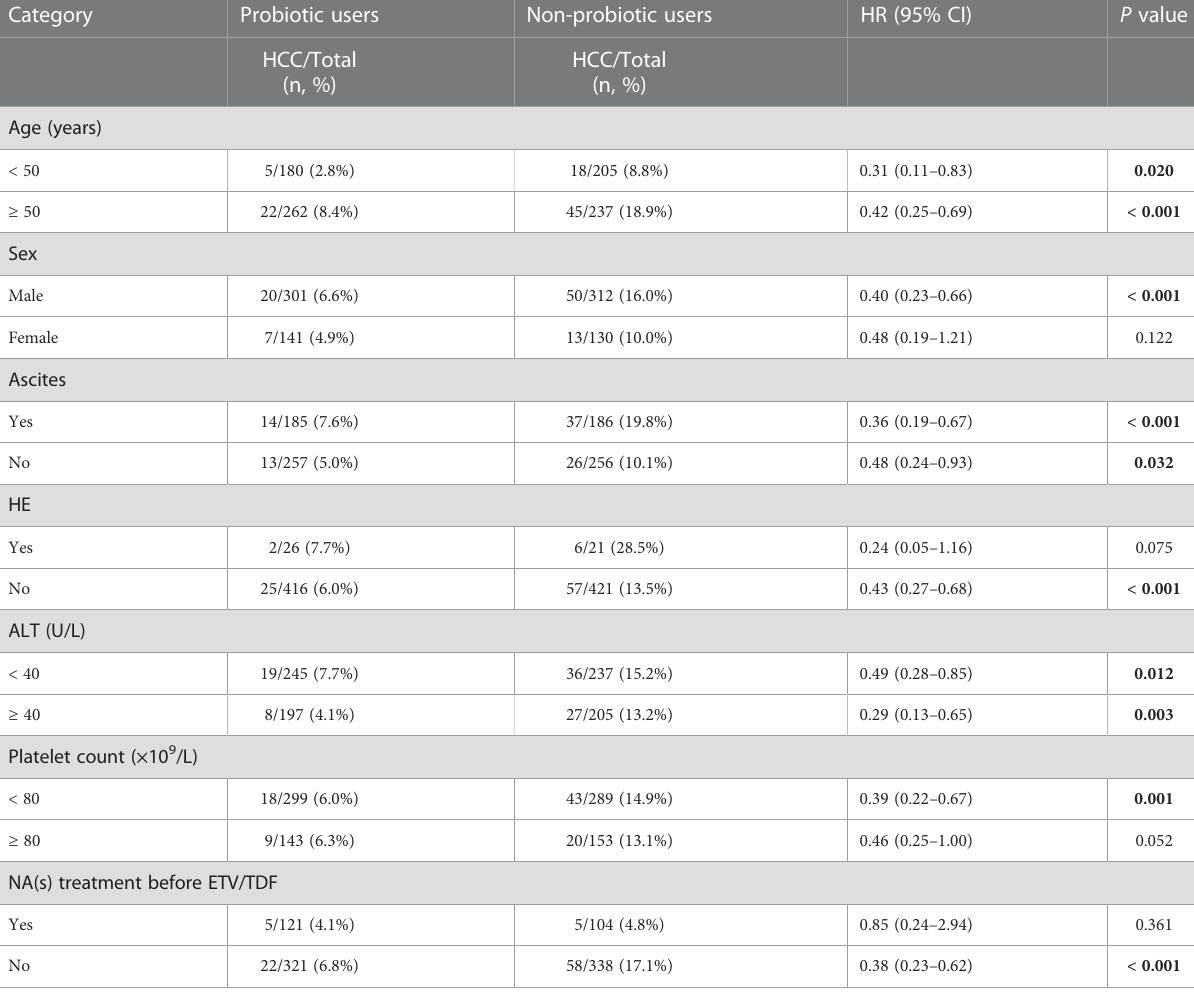
TABLE 4 Multivariable strati fi ed analyses of the association between probiotics use and HCC occurrence.